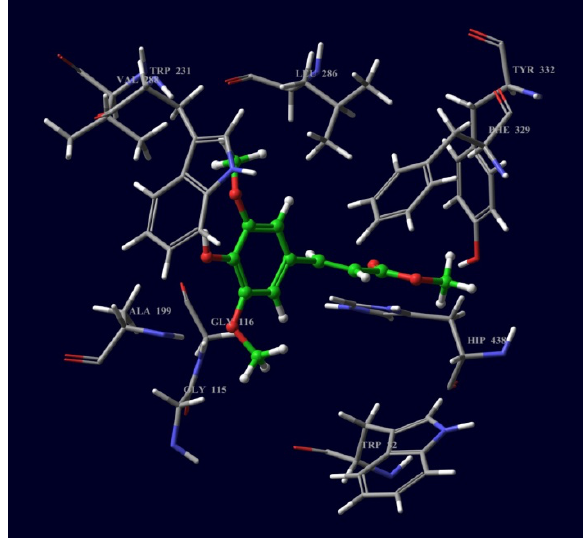
Figure 3. Compound 1 docked into the active site of Tc